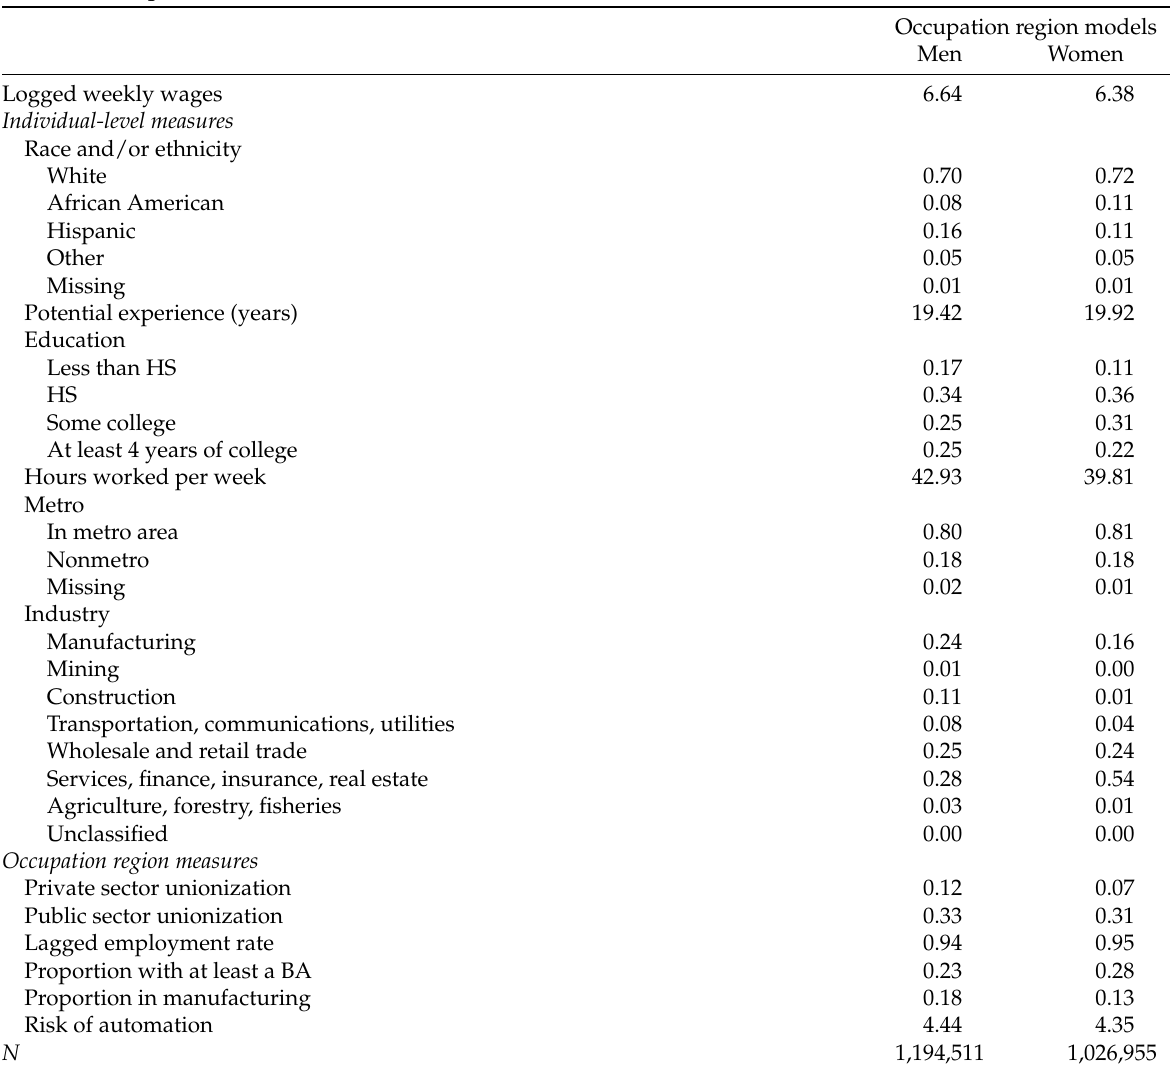
Table 1: Descriptives of CPS